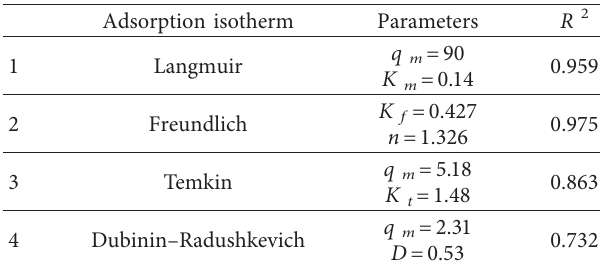
Figure 9: Dubinin model for brilliant green dye onto AC. Table 1: Isotherm models and their linearized expression with their parameters for adsorption of the BG dye on AC.